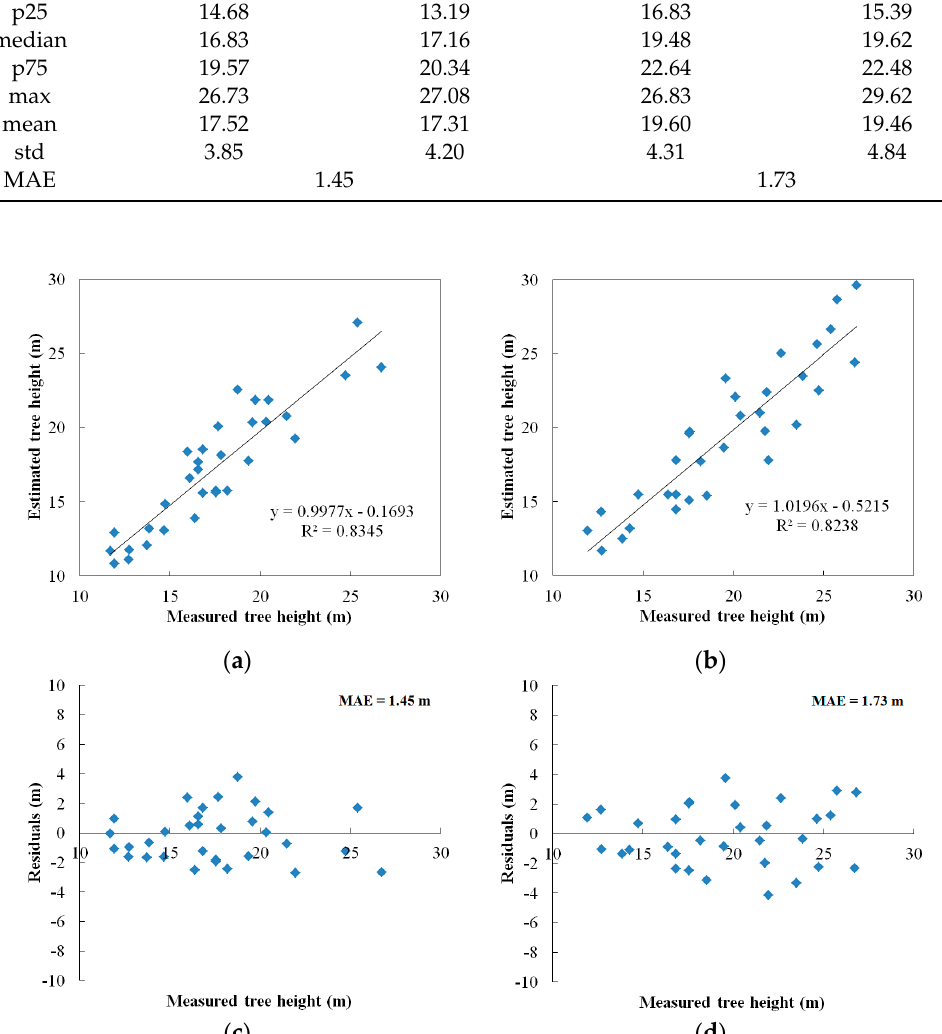
Figure 9. Linear regression models and residual plots of the ground-measured and UAV photogrammetric estimated heights. ( a ) and ( b ) are the linear regression models of Plantations 1